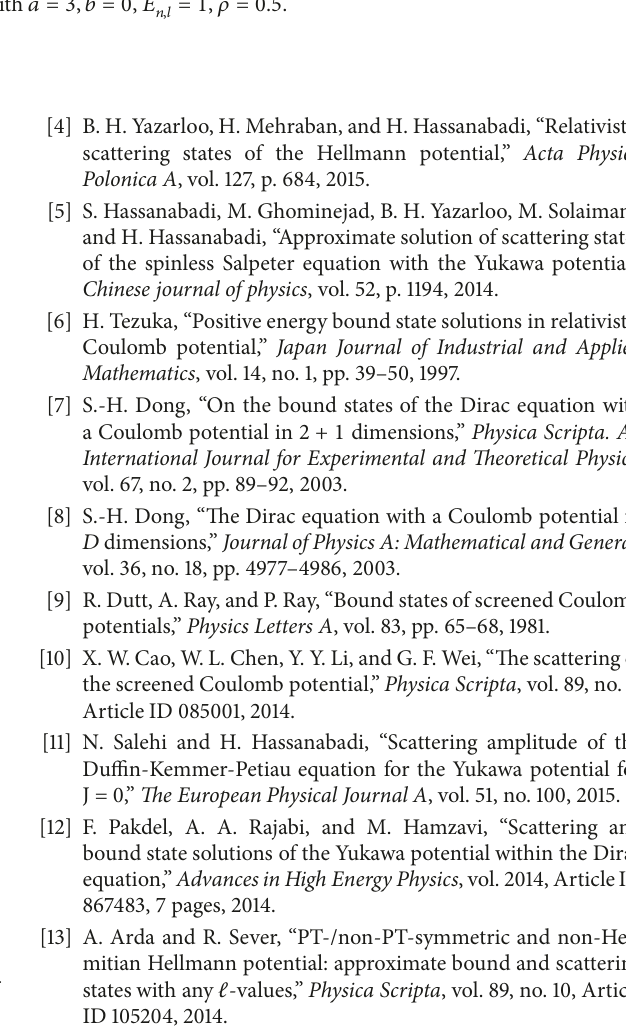
normalized eigenfunctions have been obtained. The